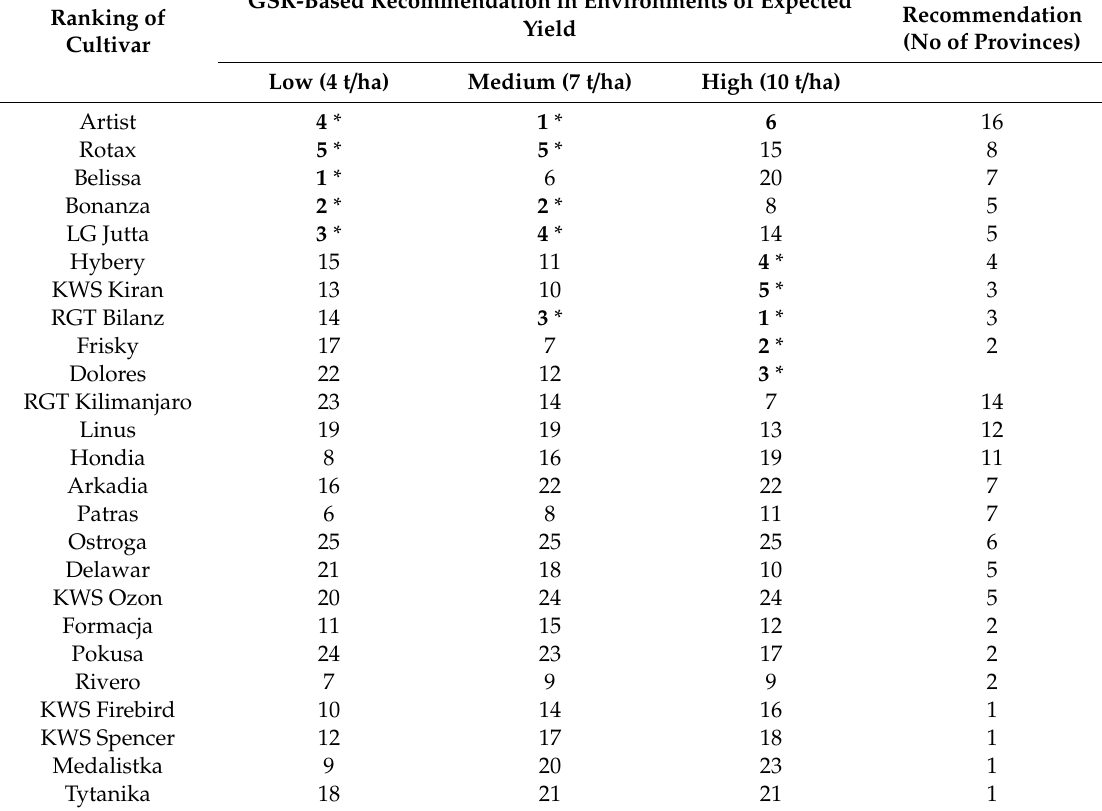
* Denotes top ranked cultivars in top five cultivars selected for recommendation. In low-, medium- and high-producing environments; (1–25) the numbers next to the cultivar names indicates the place in the ranking of each